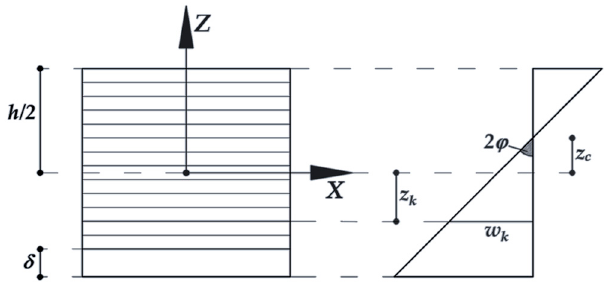
Figure 4. Strip discretization of the notched cross section and resulting distribution of axial strains/displacements.